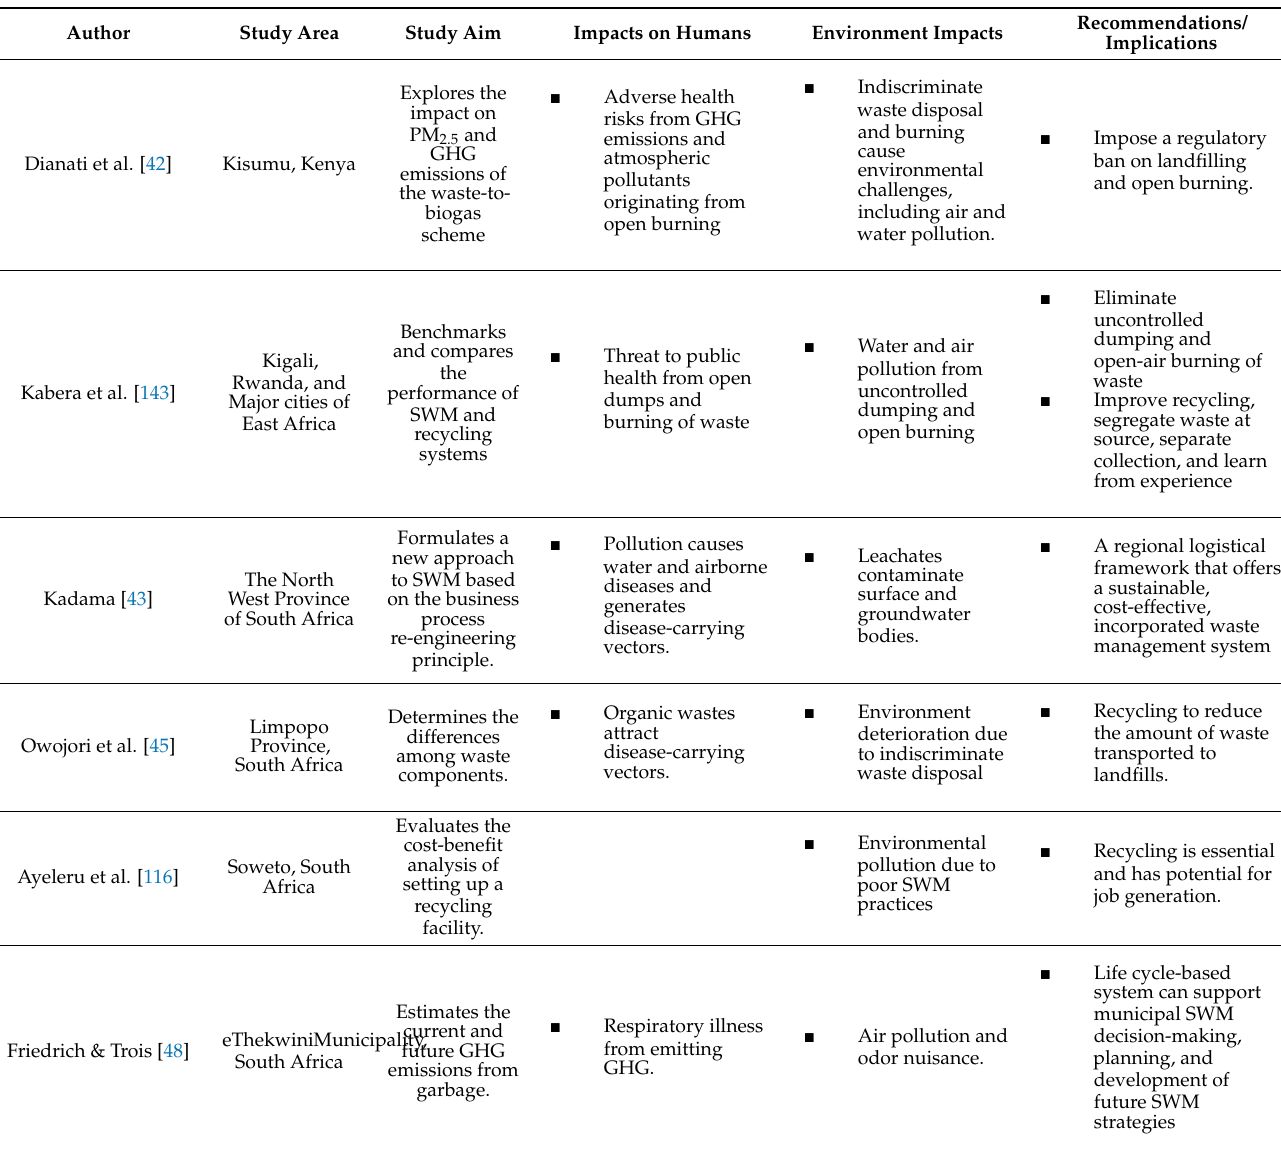
Table A3. Reviewed literature on the impacts of SWM practices in Africa (compiled by